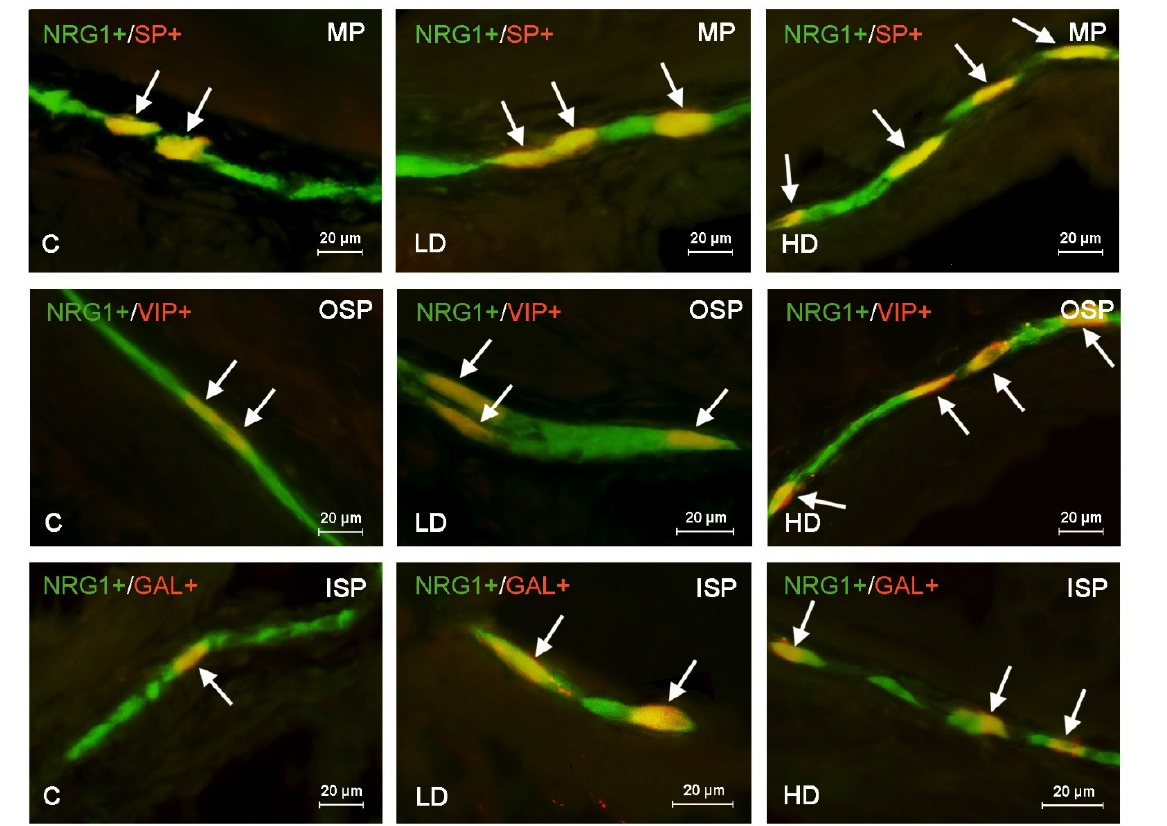
Figure 2. Distribution pattern of nerve cells immunoreactive to Neuregulin 1 (NRG1) and other neuronal substance studied—galanin (GAL, substance P (SP) or vasoactive intestinal polypeptide (VIP)—in the muscular plexus (MP), outer submucous plexus (OSP) or inner submucous plexus (ISP) in the porcine ascending colon under physiological conditions (C) and in the low dose (LD) group and the high dose (HD) group. The pictures are the result of the overlap of both stainings. Neurons immunoreactive for both NRG1 and other of the neuronal substances studied are indicated with arrows.